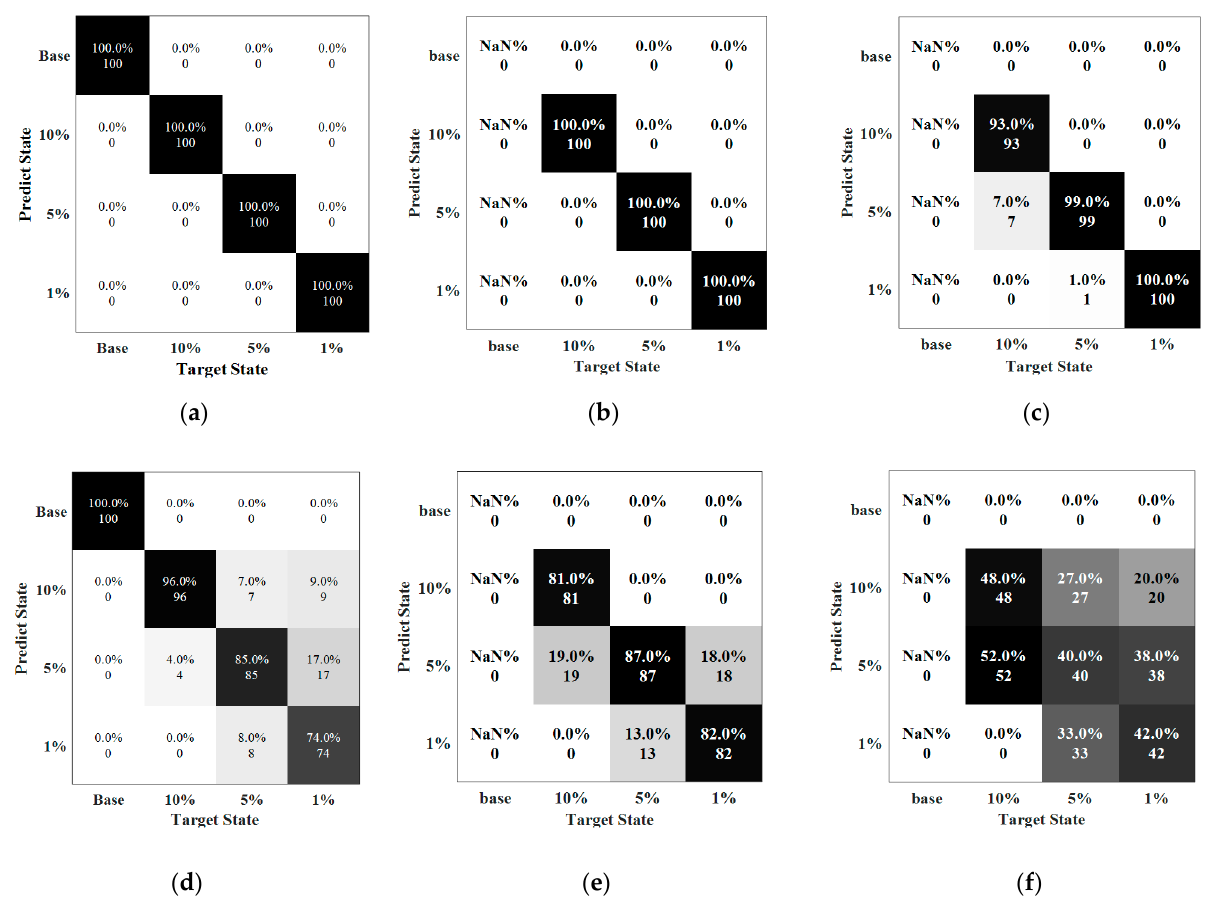
Figure 30. Detectability for pipes under different embedment conditions: ( a – f ). ( a ) Pipe without embedment (Accuracy = 100%, SNR = 100 dB). ( b ) Pipe with embedding soil (Accuracy = 100%, SNR=100 dB). ( c ) Pipe with embedding concrete (Accuracy = 97.3%, SNR = 100 dB). ( d ) Pipe without embedment (Accuracy = 88.8% , SNR = 70 dB); ( e ) Pipe with embedding soil (Accuracy = 82% , SNR = 70 dB); ( f ) Pipe with embedding concrete (Accuracy = 42% , SNR = 70 dB).